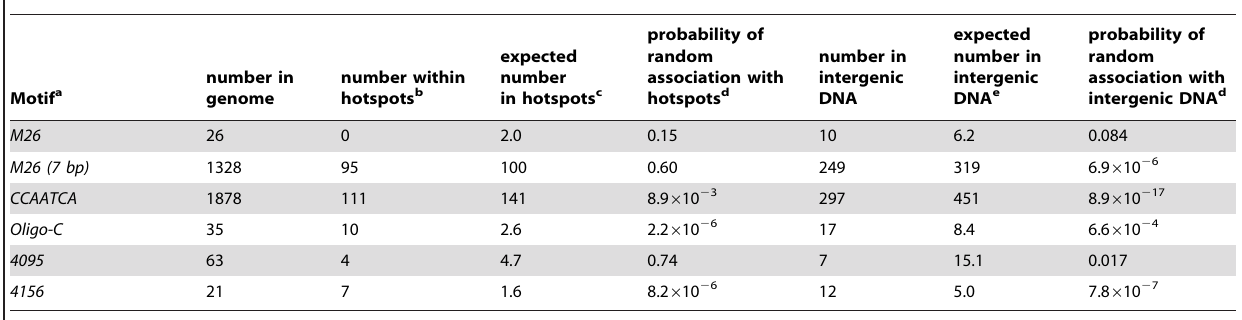
Table 2. Hotspot motif correlations with DSBs.